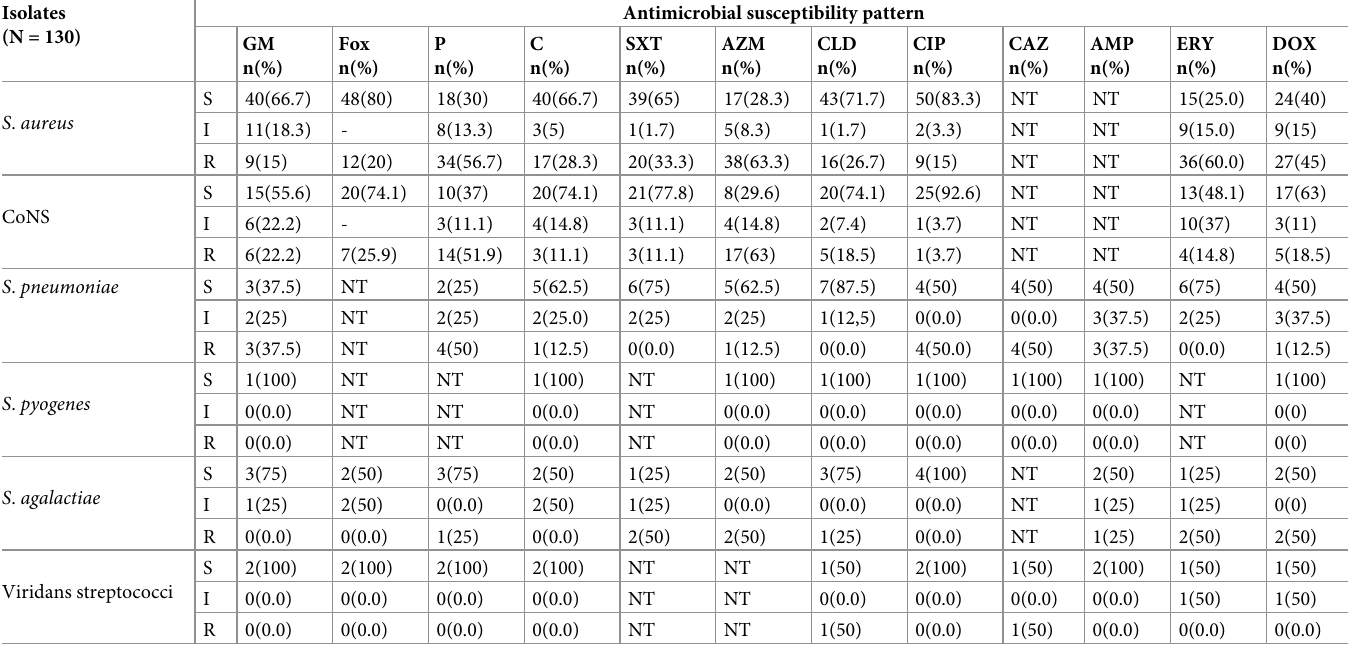
Table 3. Antibiotic susceptibility pattern of culture-confirmed Gram-positive bacteria isolated from EOI patients at DMCSH, Northwest Ethiopia, 2021. Isolates (N =